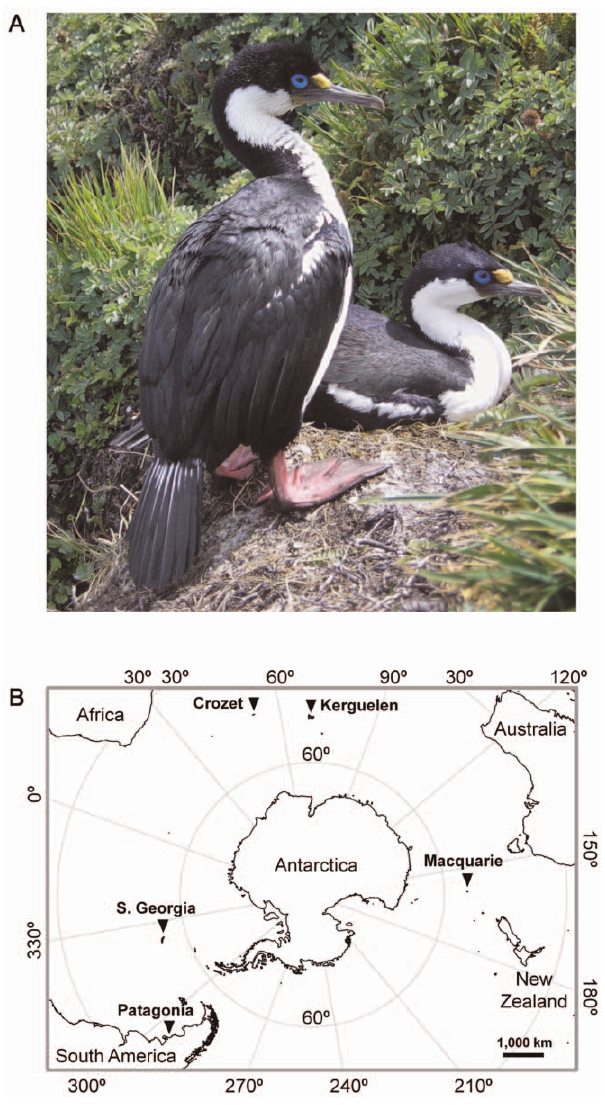
Figure 1. Distribution of Blue-eyed Shag colonies. (A) Blue-eyed Shag breeding pair at Crozet, with male standing in the foreground (photo: Carolyne Dodelinger). (B) Position of the Blue-eyed Shag studies that were reviewed in this paper.